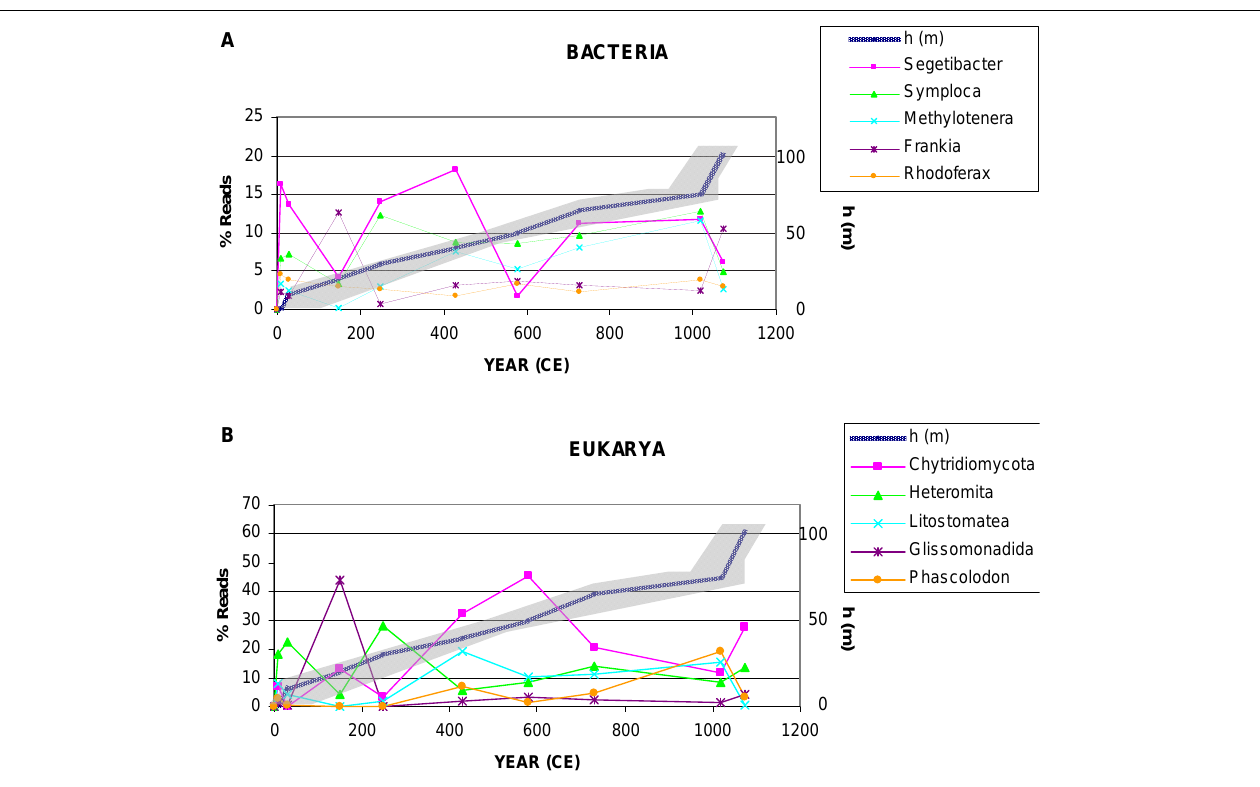
FIGURE 7 | Representation of the most abundant genera of bacteria and microeukaryotes in the ice samples. The depth-age model is based on linear interpolation of 14 C data calculated in Moreno et al. (2021).